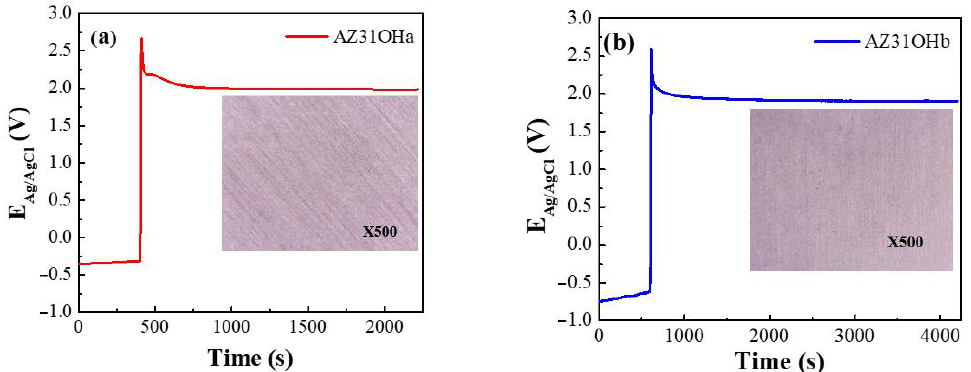
Figure 1. OCP behaviour for the AZ31 anodising samples using NaOH 1 M as the electrolyte, 3 V polarization to ( a ) 0.5 and ( b ) 1 h, respectively.